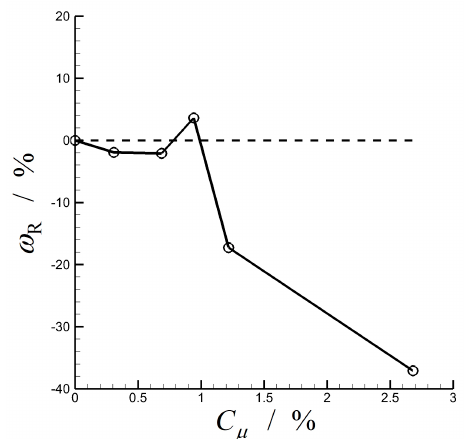
ω ) of the curved diffuser versus momentum